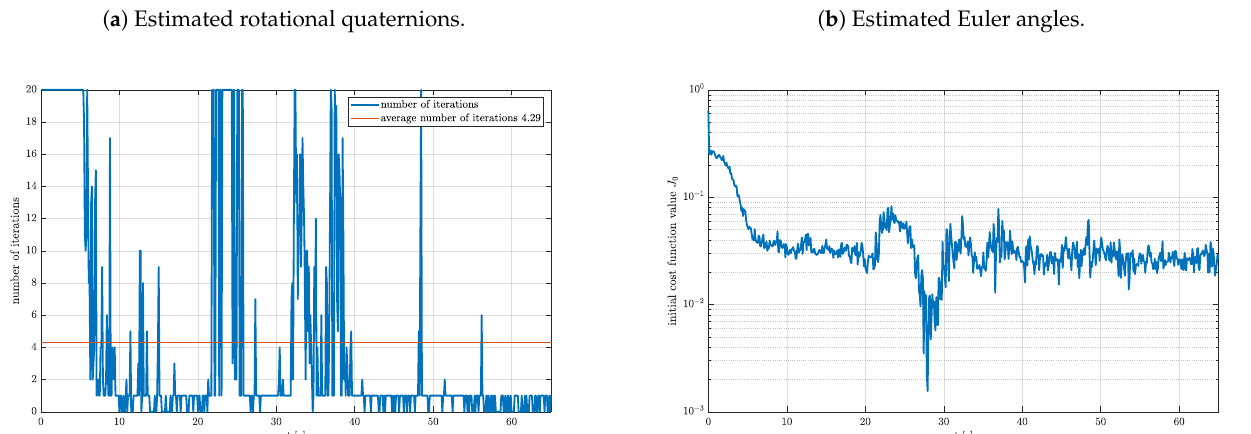
Figure 9. Experimental results obtained with parameters µ = 0.7, q 0 = G max = 1 × 10 − 2 , and K =